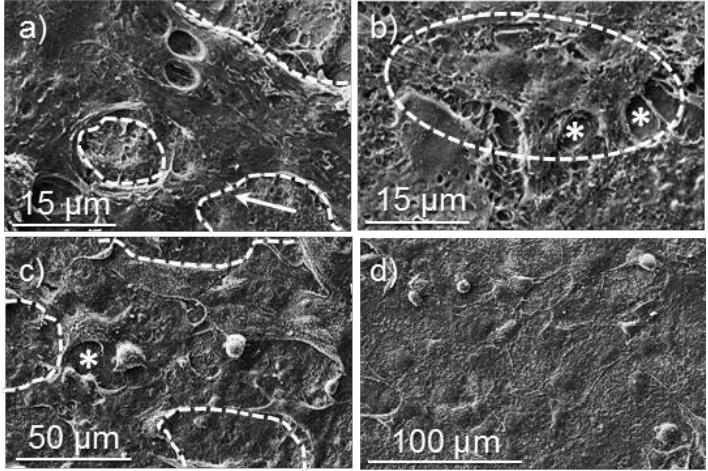
Figure 13. SEM micrographs showing cellular adhesion and proliferation on surfaces of poly(glc-5-glc 6) electrospun scaffolds: ( a ) COS-7 cell adhesion on an unloaded sample; ( b ) VERO cell adhesion on an unloaded sample; ( c ) COS-7 cell proliferation on an unloaded sample; ( d ) COS-7 cell proliferation on loaded samples prepared from 5% KTP electrospinning solution. Dashed lines highlight cell profiles except for ( d ) where a monolayer was formed.